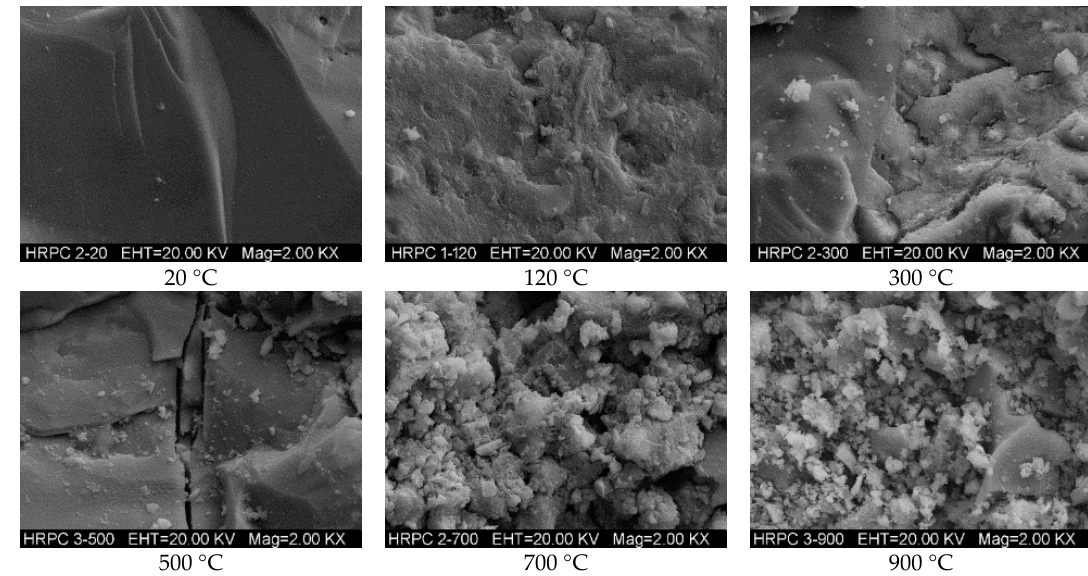
Figure 18. SEM micrographs of RPC matrix at different temperatures. Materials 2019 , 12 , x FOR PEER REVIEW